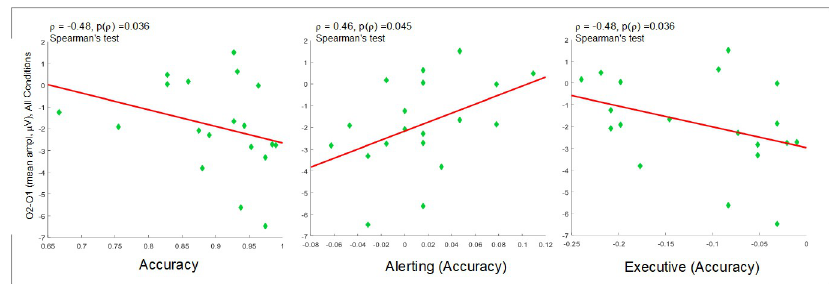
Fig 9. Correlation between O2-O1 asymmetry and ANT performance. O1-O2 (mean amplitude) of AllCd and accuracy (left), and efficiencies of the alerting (center) and executive networks (right) regarding accuracy.